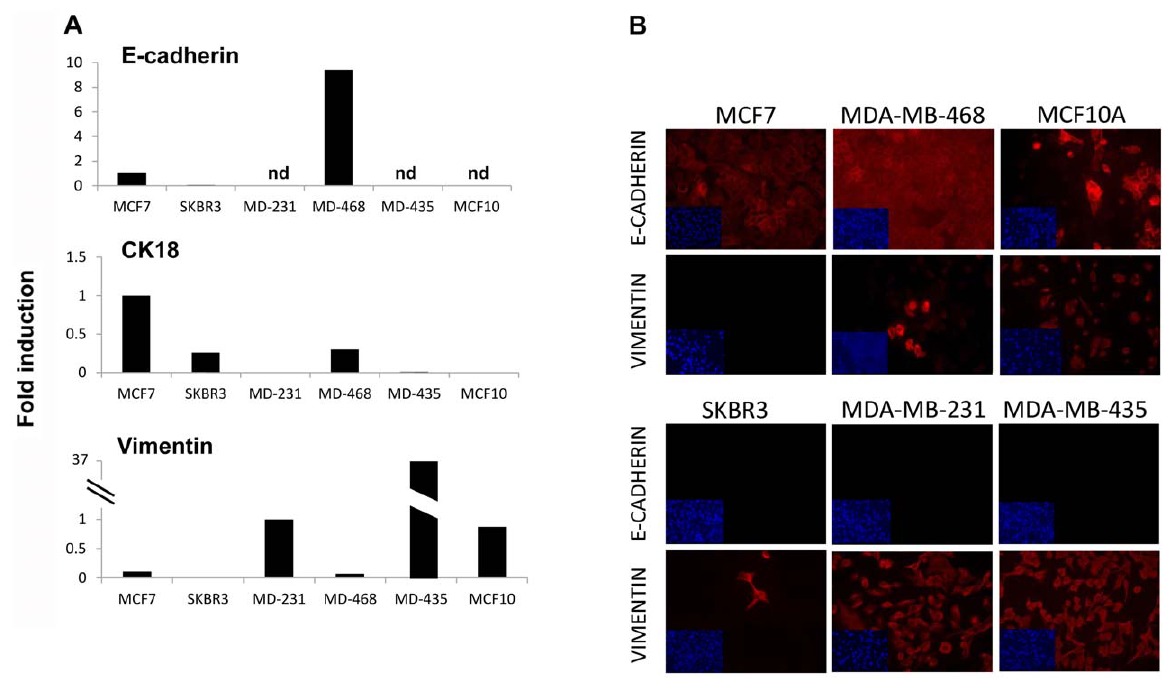
Figure 5. Epithelial and EMT marker gene expression in MCF7, SKBR3, MDA-MB-231, MDA-MB-468, MDA-MB-435 and MCF10A cells. A) The gene expression of epithelial cell markers (E-cadherin, cytokeratin 18) and the mesenchymal cell marker vimentin were examined by RT and real-time PCR using 200 ng of RNA. E-cadherin and CK18 are represented compared to the luminal MCF7 cell line expression and vimentin is represented compared to the MDA-MB-231 cell line. Cyclophilin A gene was used to normalize gene expression. B) Immunofluorescence staining of the epithelial E-cadherin and the mesenchymal vimentin markers in MCF7, MDA-MB-468, MCF10A, SKBR3, MDA-MB-231 and MDA-MB-435 cells. DAPI staining appears minimized in each picture. 40 6 magnification was